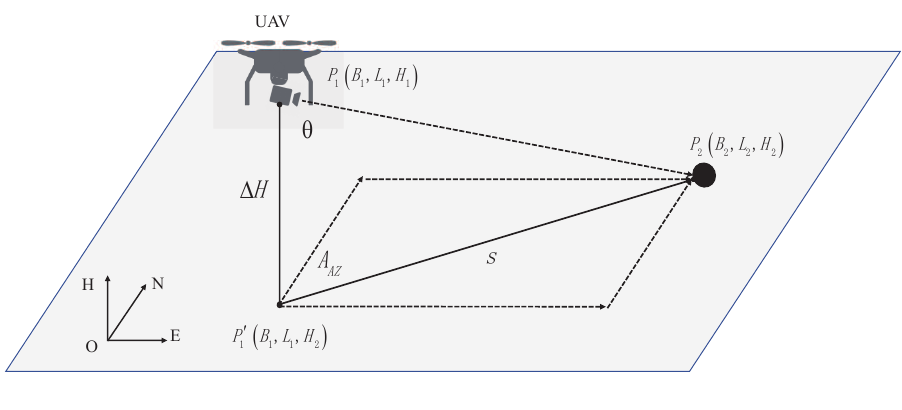
Figure 3. Schematic diagram of the spatial geometric relationship between the UAV and target